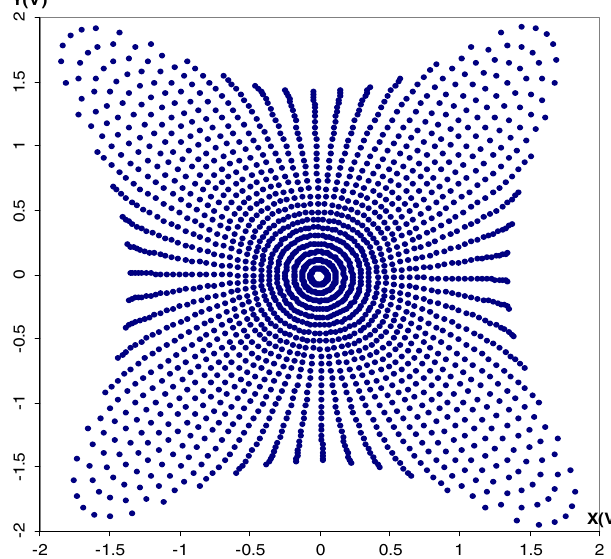
FIG. 16. (Color) Mapping of the BPM position characteristics moving the stimulus (rod center conductor, i rod ¼ 0 : 3 mA ) along polar coordinates. The radius was incremented by 1 mm. X and Y are directly the measured positions by the log-ratio Bergoz